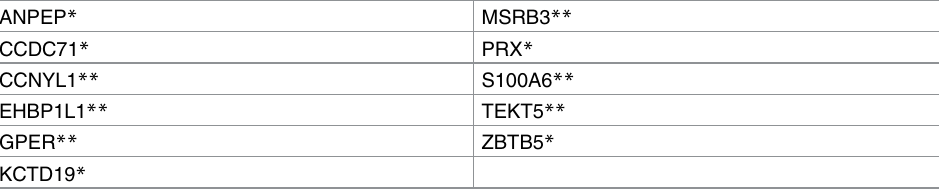
Table 5. Proteins expressedin endothelial cells of different sized vessels. Proteinsin EC or EC/VSMC that displayeddifferences in expressionaccordingto the size of the vessel are shown.